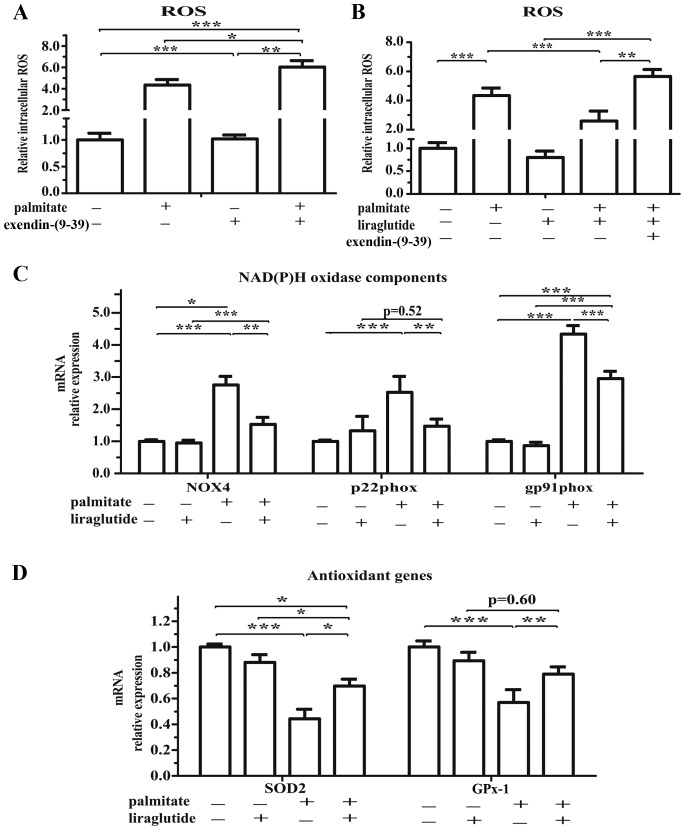
Glucagon-like peptide-1 receptor (GLP-1R) signaling exerts inhibitory effects on the generation of reactive oxygen species (ROS). (A and B) Following pre-incubation with 100 nmol/l liraglutide and/or 0.5 µmol/l exendin-(9-39) for 2 h, followed by exposure to 0.5 mmol/l palmitate for 48 h, ROS levels were detected byDCFH-DA, and (C) the mRNA expression of NAD(P)H oxidase components [including NADPH oxidase 4 (NOX4), p22phox and gp91phox], and (D) antioxidant genes [superoxide dismutase 2 (SOD2) and glutathione peroxidase-1 (GPx-1)] was detected by qPCR. n=3 separate isolated islet preparations; *p<0.05; **p<0.01; ***p<0.001.